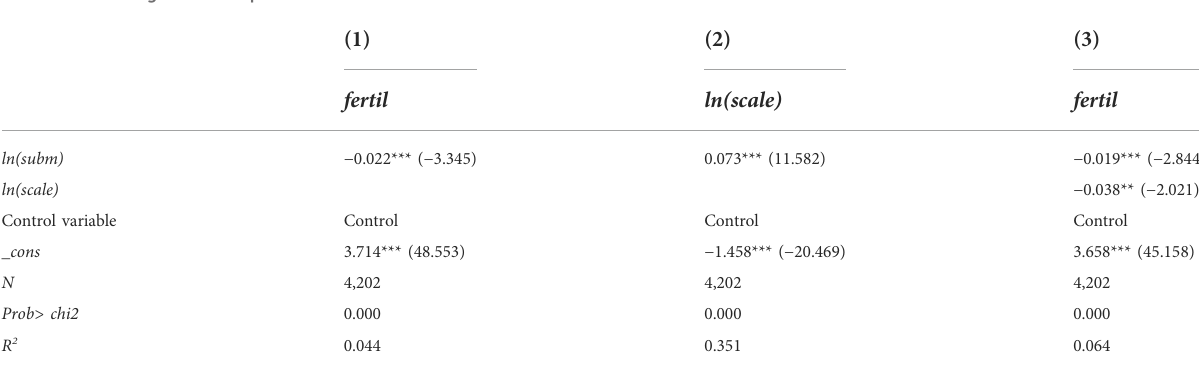
TABLE 4 Mediating effect of operation scale.